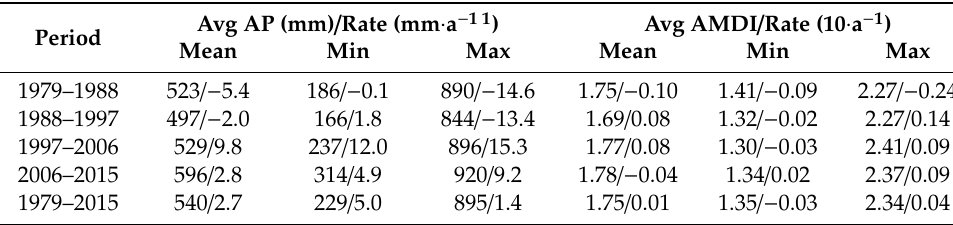
Table 4. The regional mean and extreme values of averaged AP and AMDI with inclination rates during different periods over the SRYR.